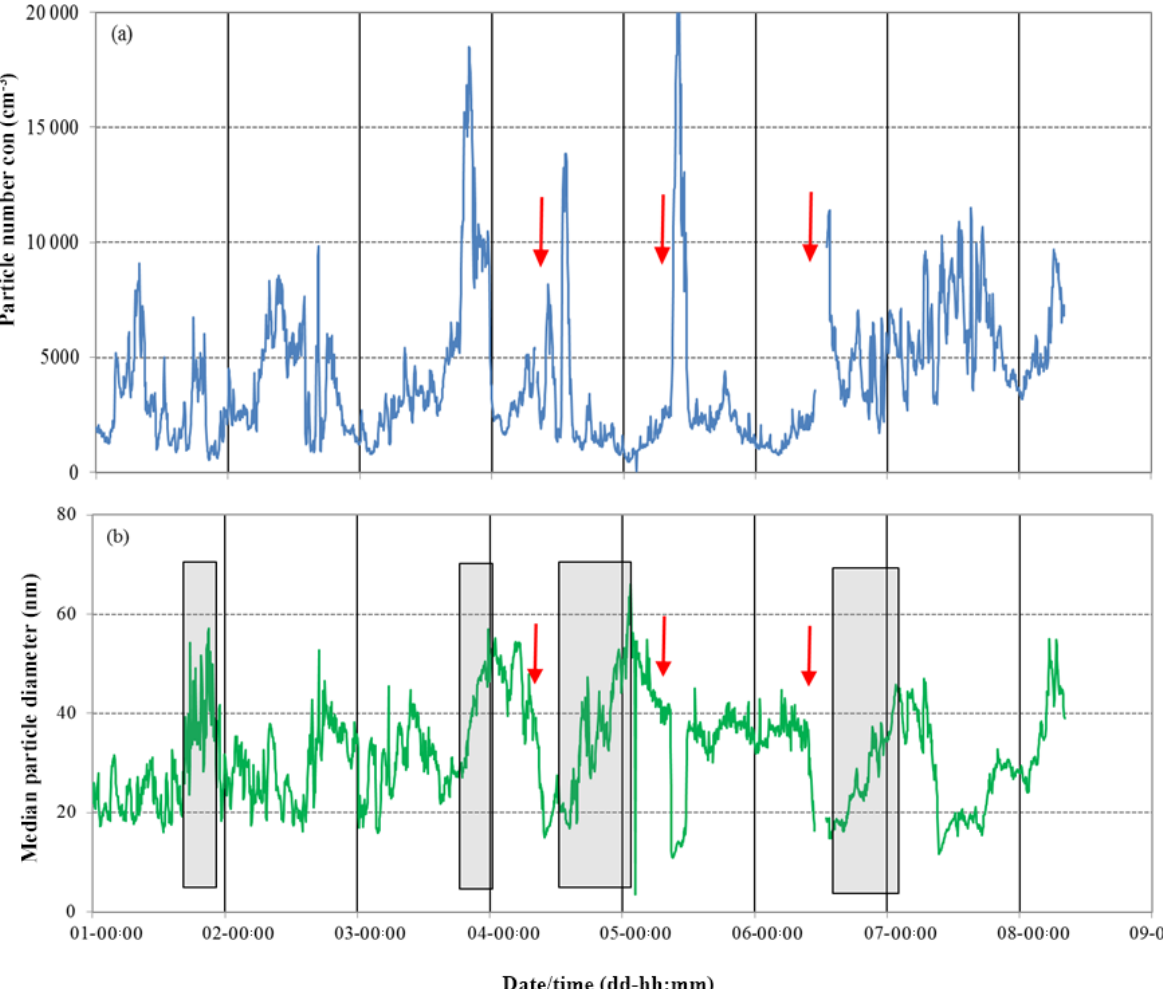
Figure 5. (a) The total PNC and (b) median particle diameter from the SMPS during 1–7 June 2012. Red arrows and gray boxes represent the day time NPF events and the growth events,